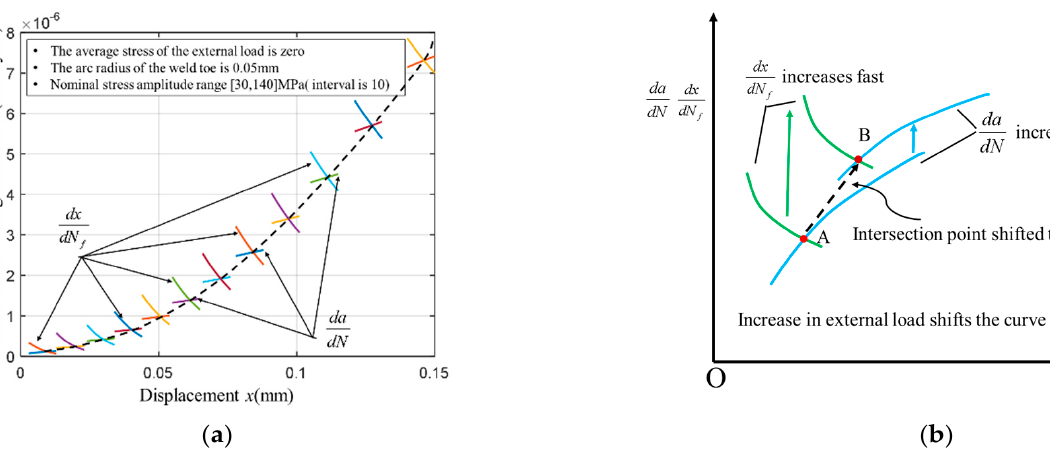
(cid:3031)(cid:3051) (cid:3031)(cid:3028) and . and da (cid:3031)(cid:3015) (cid:3281) (cid:3031)(cid:3015) dN f dN